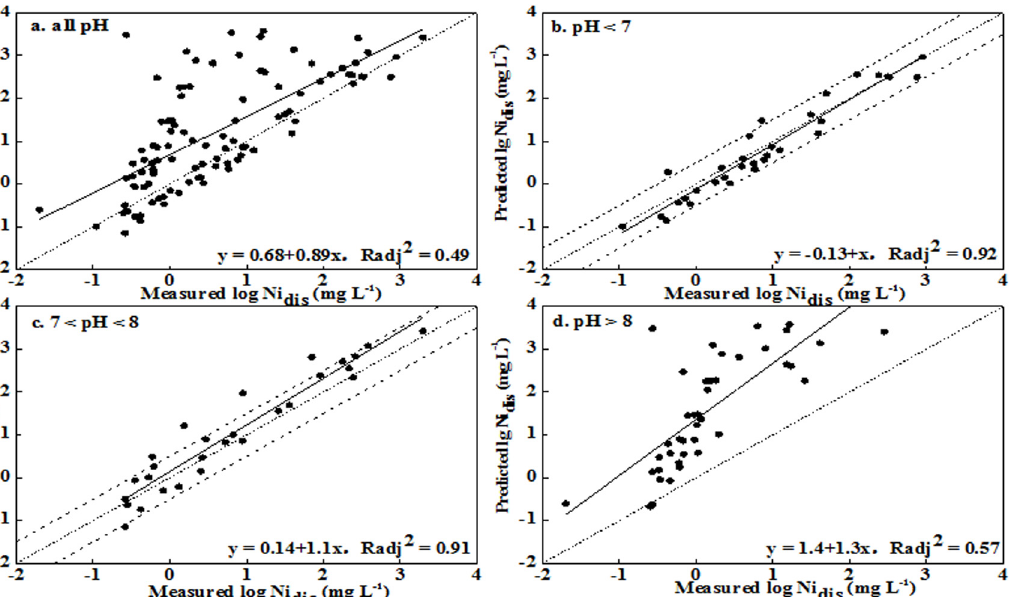
Fig 3. Measured soluble Ni concentration versus predicted Ni concentration using WHAM VI in unleached soils (Ni dis represented the soluble Ni concentration in soil pore water).